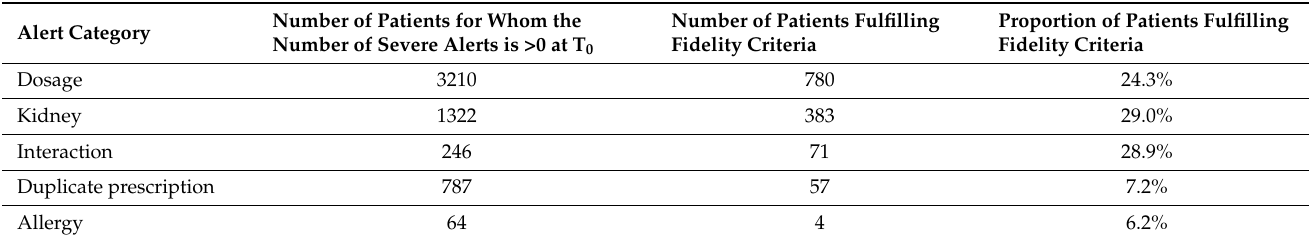
Table 7. Proportion of patients fulfilling the Fidelity criteria.